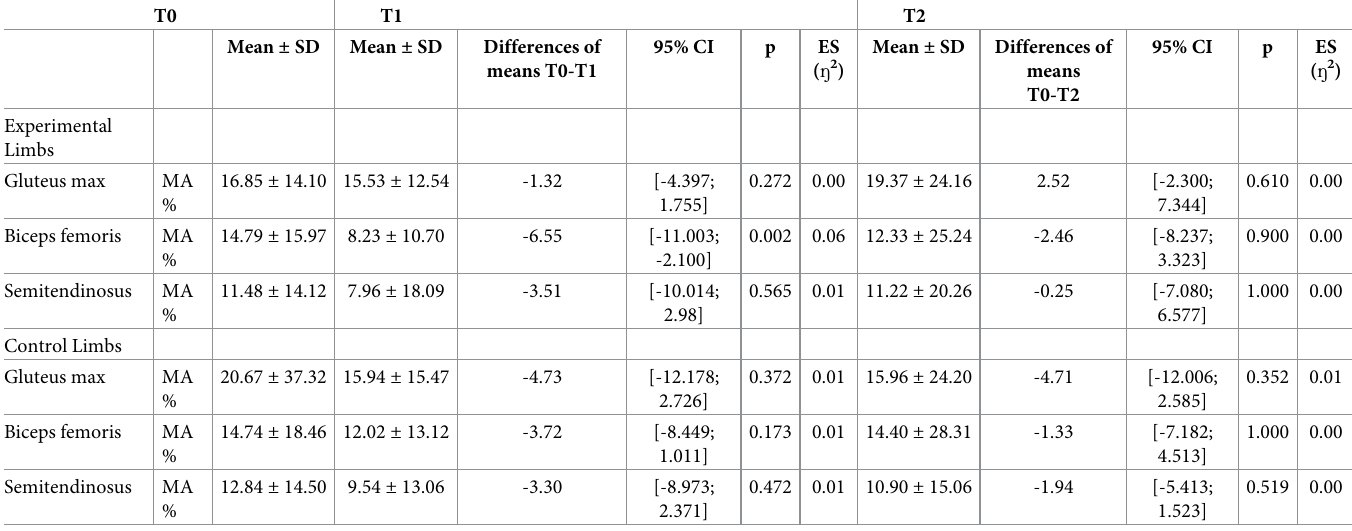
(Table 2), and compared to the control group in the two moments of the study (Table 3). Table 4. Intra-group electrical activity